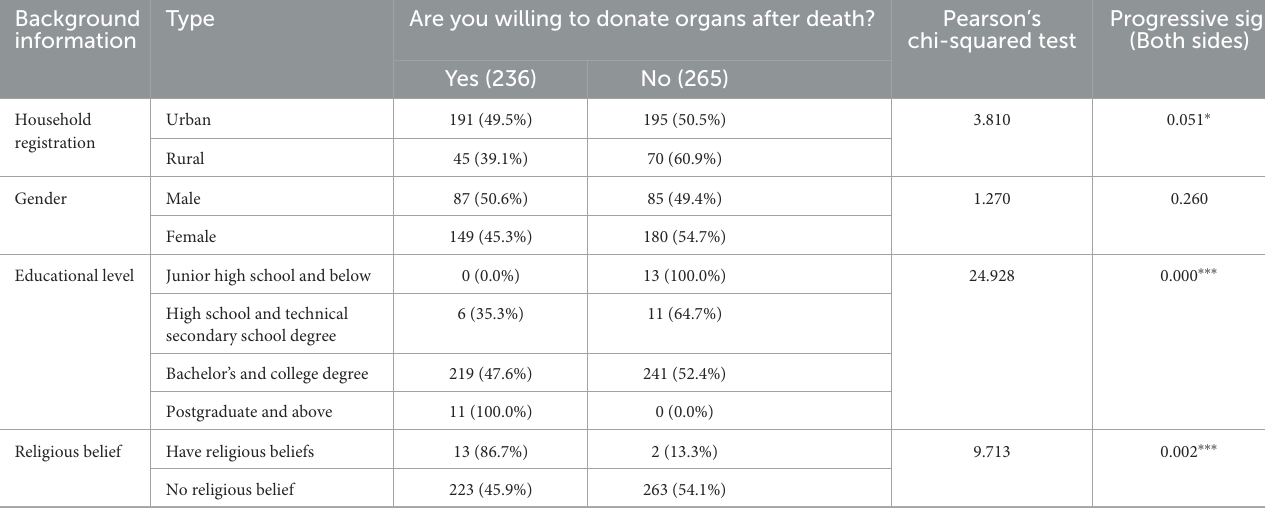
TABLE 3 Background information and organ donation awareness. Background